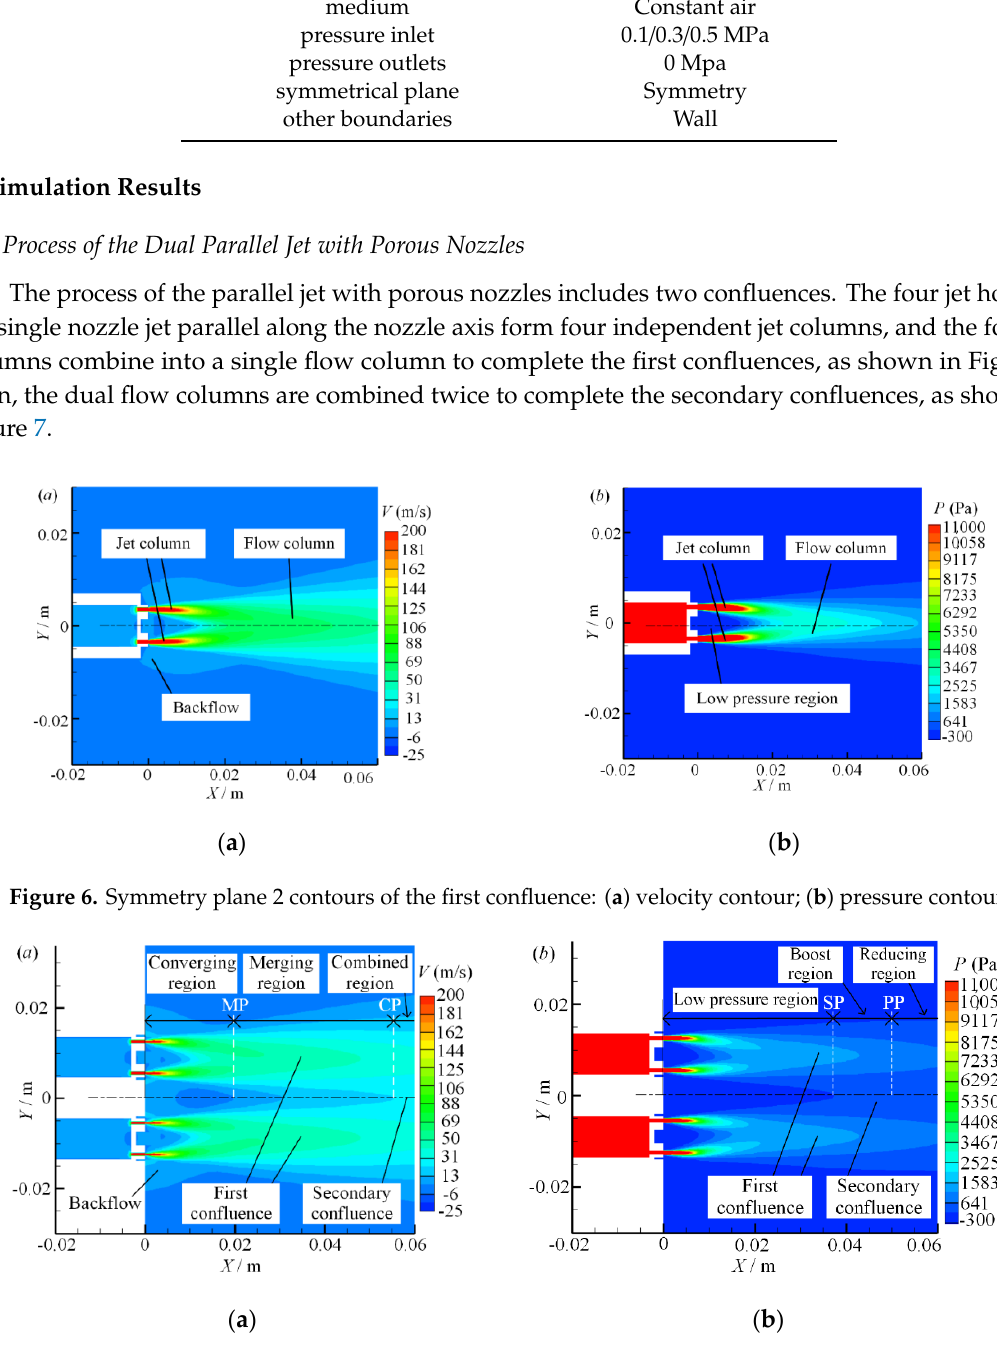
Figure 7. Symmetry plane 2 contours of the secondary confluence: ( a ) velocity contour; ( b ) pressure contour.